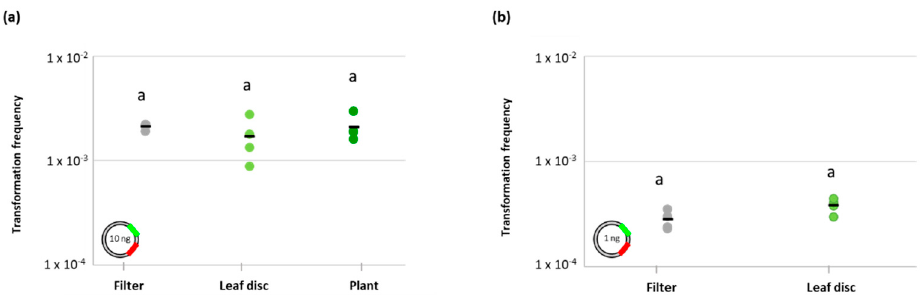
Figure 3. Natural transformation of A. baylyi BD413 under different experimental setups. Transformation frequency of A. baylyi BD413 was calculated using 10 ng ( a ) and 1 ng ( b ) of plasmid pZR80(gfp) on nitrocellulose membrane filters, leaf discs, and in planta. For all conditions, the black line indicates the average value of four biological replicates. The same letter (a) indicates no significant differences according to ( a ) ANOVA test ( p -value > 0.05) or ( b ) Student’s t -test ( p -value > 0.05).